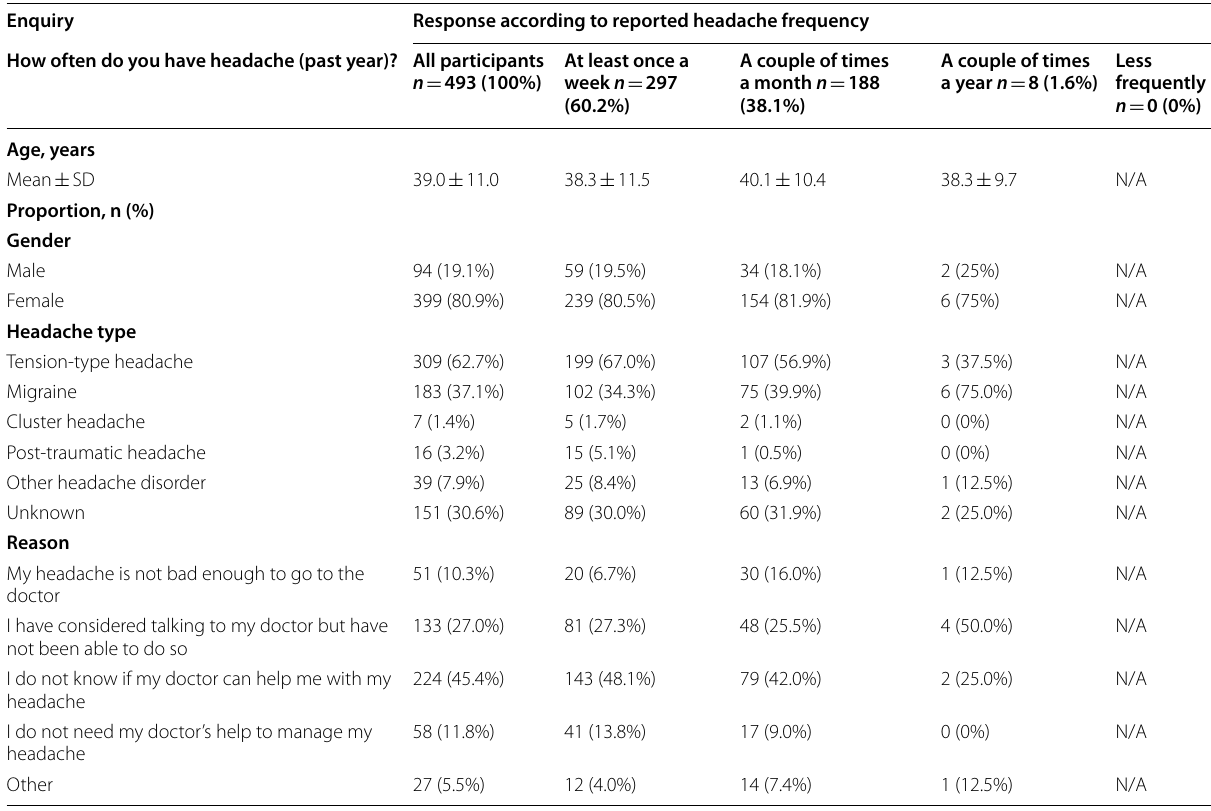
Table 6 Characteristics of participants not seeking medical advice despite agreeing or strongly agreeing that headache is a burden on everyday life, and reasons for not doing so Enquiry Response according to reported headache